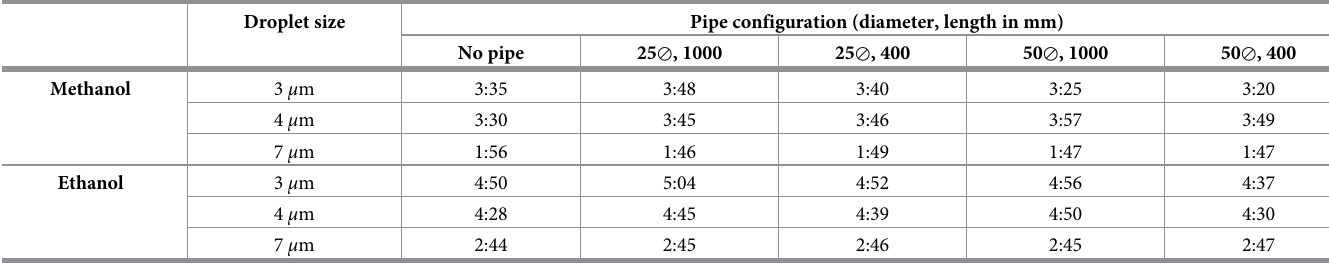
Table 4. t nebul for 2ml of carrier in minutes:seconds as a function of droplet size and pipe type. Droplet